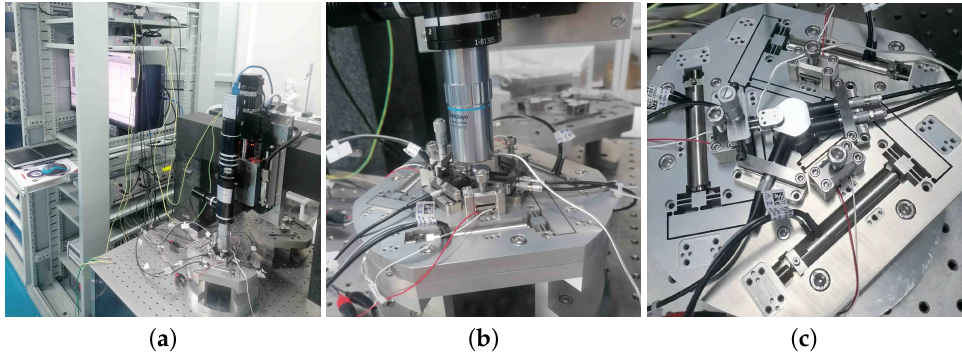
Figure 16. Instrumental setup to test the prototype of the 6-RRRR NPS. ( a ) Complete setup; ( b ) NPS setup; ( c ) sensors and